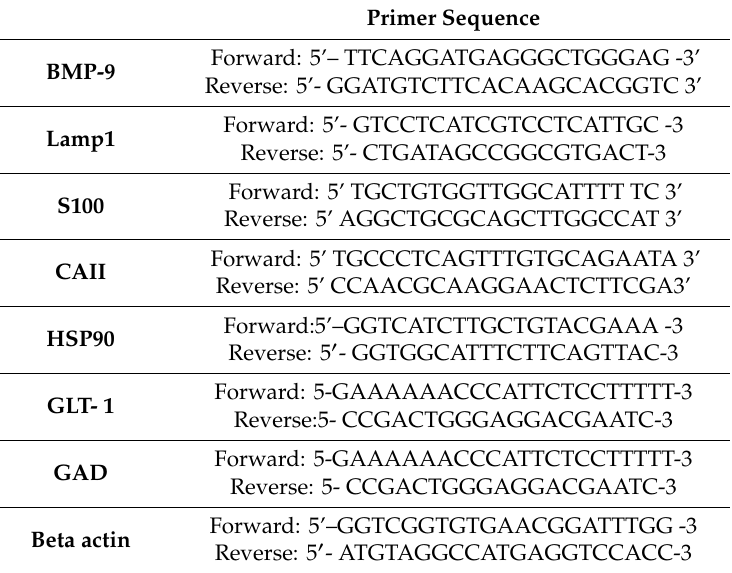
Table 1. The primer sequence of the studied